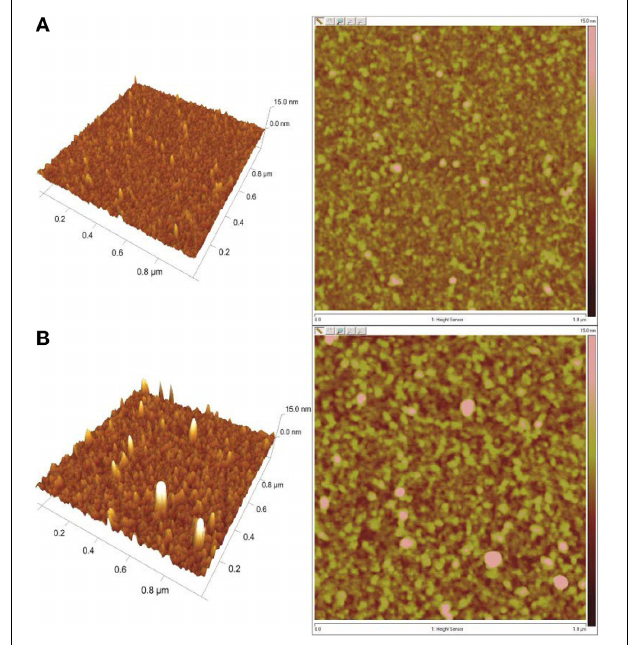
FIGURE 4 | AFM images of the surfaces irradiated (A) in the absence of insulin (DR/Pec) and (B) in 36 μ M insulin solution